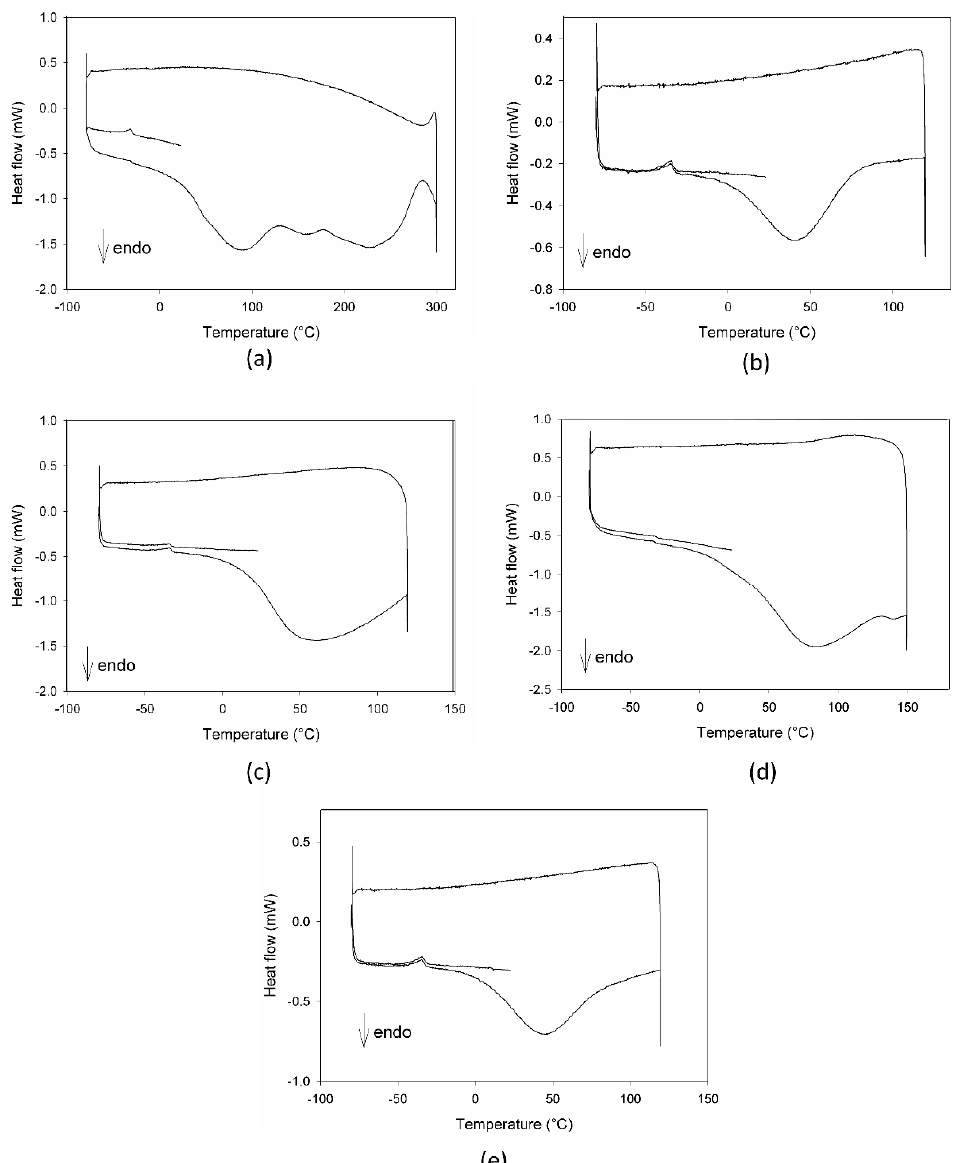
Figure 1. DSC profiles of Moradyn corn cob extract-MCE ( a ), cyanidi-3- O -glucoside-C3G ( b ), Arabic gum-AG ( c ), mixture MCE-20% AG, w / w ( d ), and mixture C3G-20% AG, w / w ( e ).